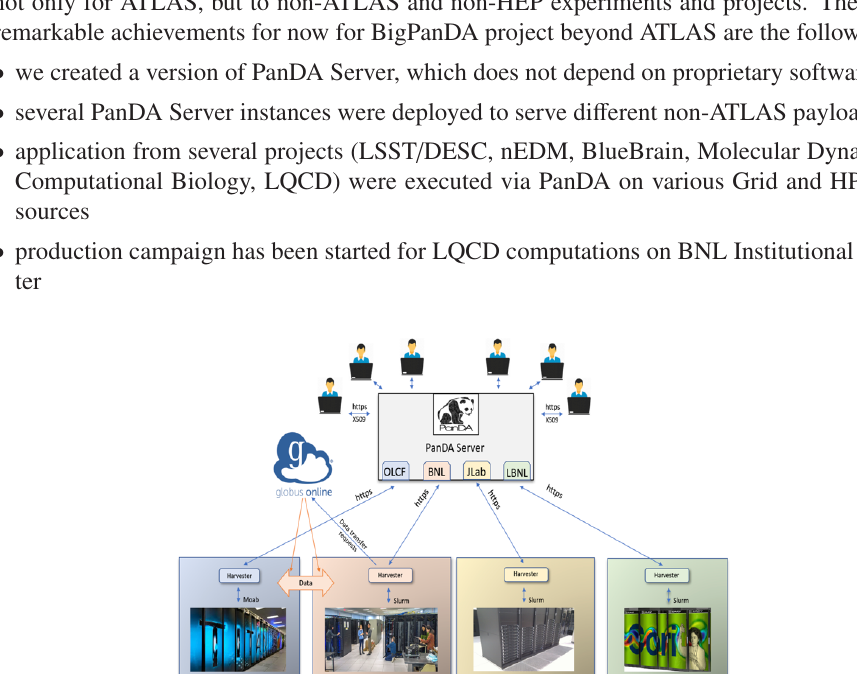
Figure 4: Future computing environment for Lattice